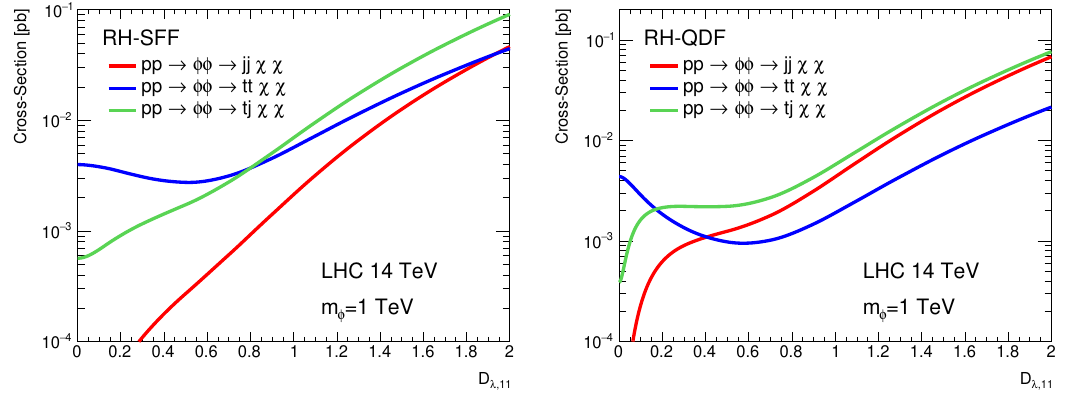
Figure 3 . Branching fractions for three final states: jj + E miss a function of the coupling D RH-QDF benchmark.